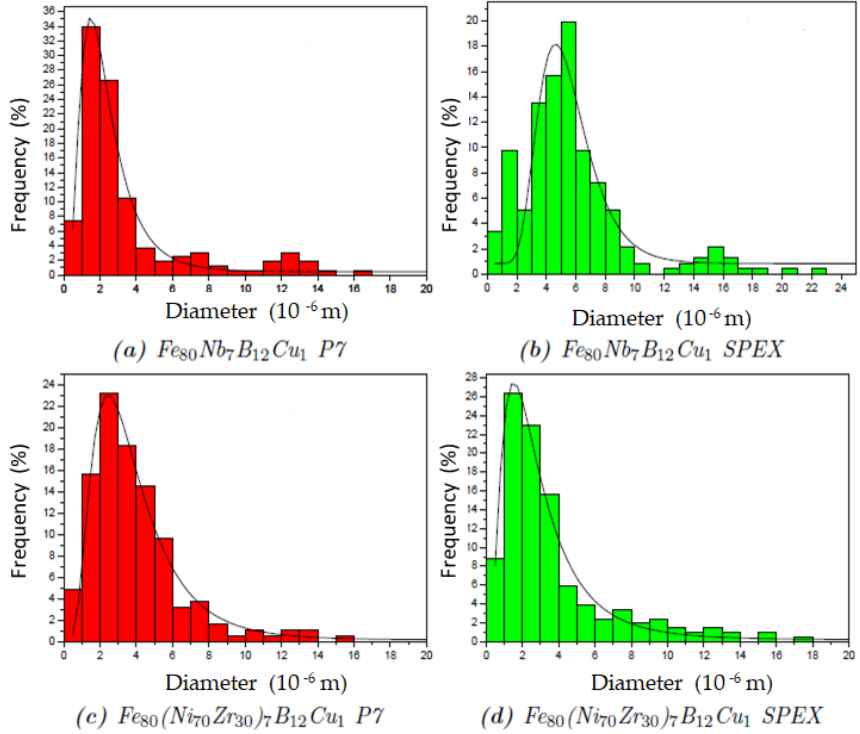
Figure 4. Particle size frequency distribution after 80 h milling of samples: ( a ) P7—A, ( b ) SPEX—A, ( c ) P7—B, and ( d ) SPEX—B. Table 5. Parameters (mean, μ, and shape parameter, σ) of the log-normal distribution.